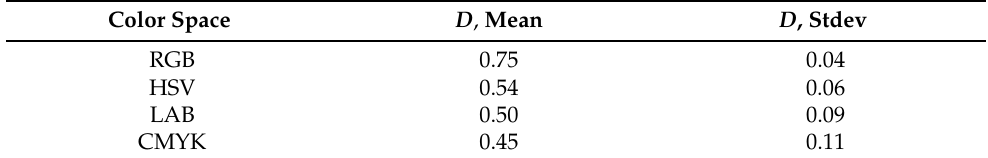
Table 1. Summary of color decorrelation ( D ) measurements (Equation (1)) in RGB, HSV, CIELAB and CMYK color spaces for a test sample of randomly selected 100 greenhouse